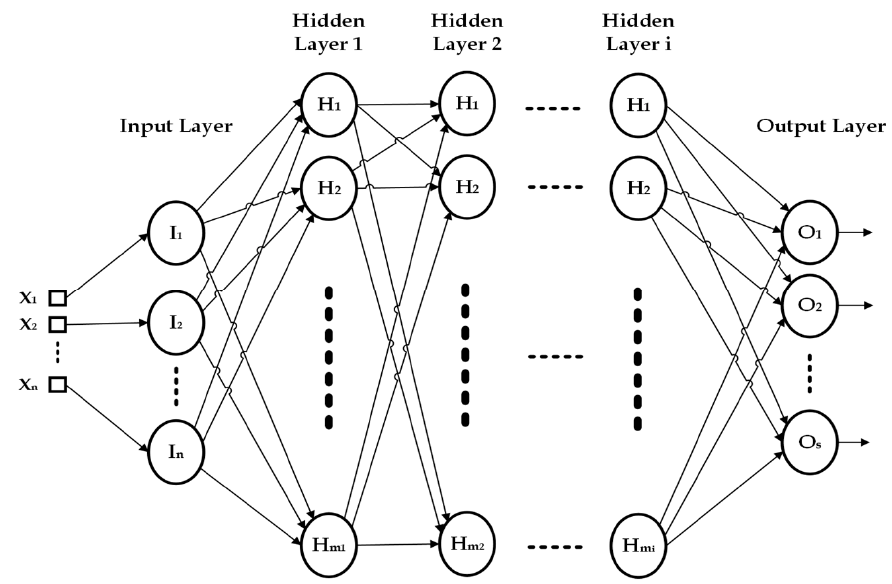
Figure 1. ANN structure.